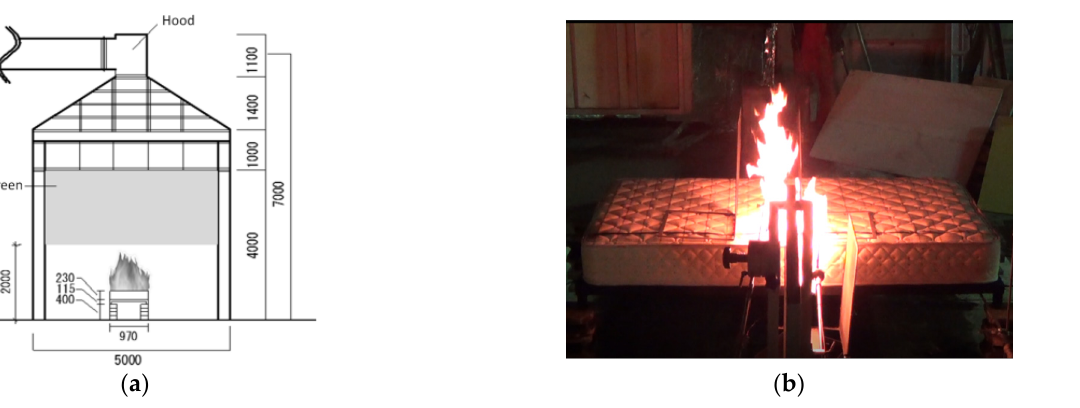
Figure 1. Experimental setup of open space test: ( a ) arrangement of the test body (unit: mm); ( b ) photo in mattress test (HB = 515 mm).